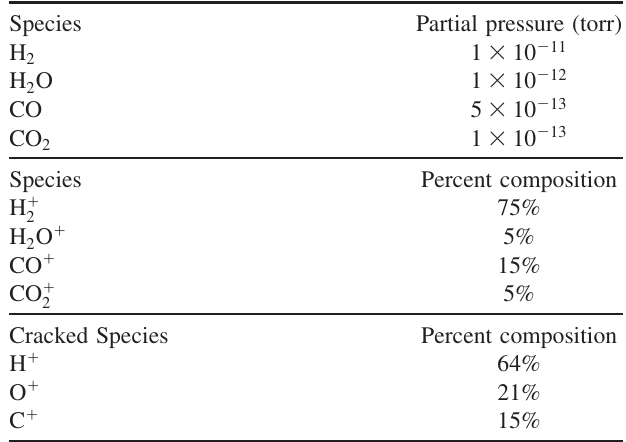
TABLE I. Top: Partial pressures of the dominant residual gas species, as measured by RGA within the DC gun chamber. Middle: Ion beam composition, calculated from partial pressure and Bethe ionization cross section. Bottom: Percent composition of a fully cracked ion